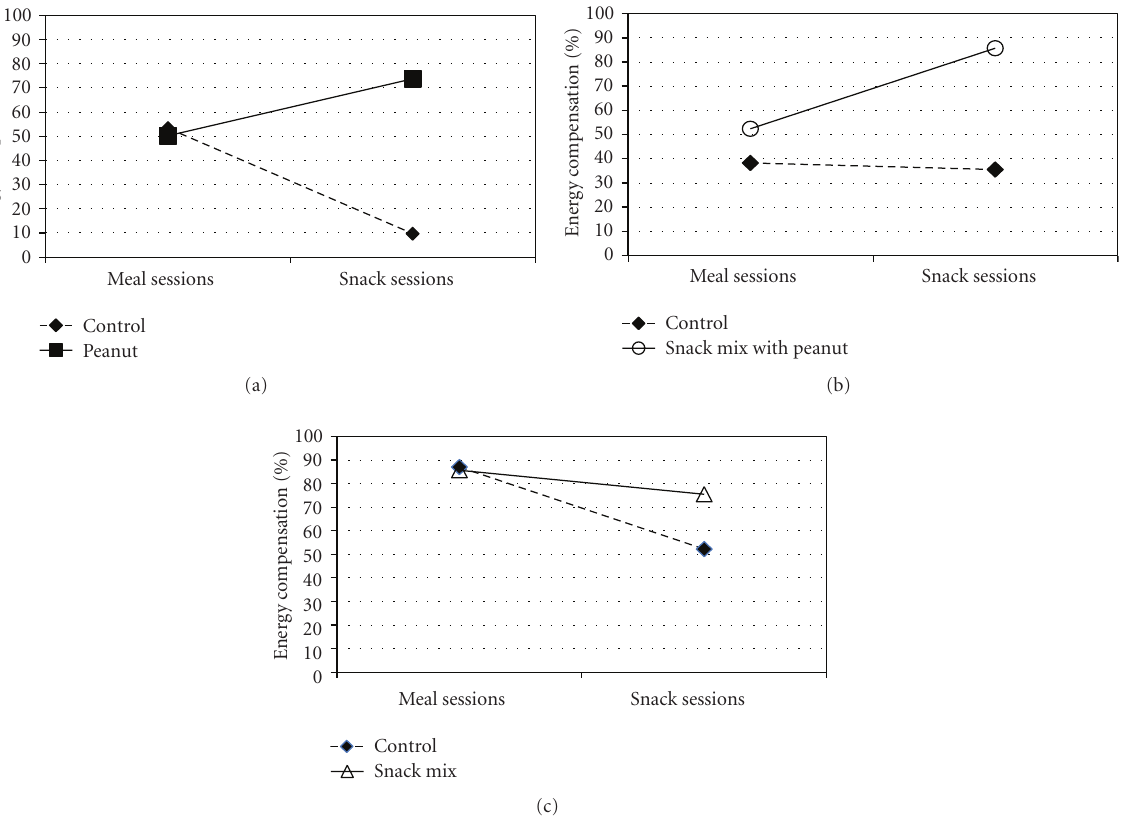
Figure 2: Mean energy compensation observed after ingestion of the test loads. Data are mean values of energy compensation due to the ingestion of the